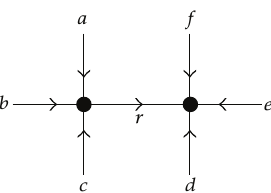
Figure 7: Tree-level diagram. The label r counts the derivatives acting onto the internal propagator.